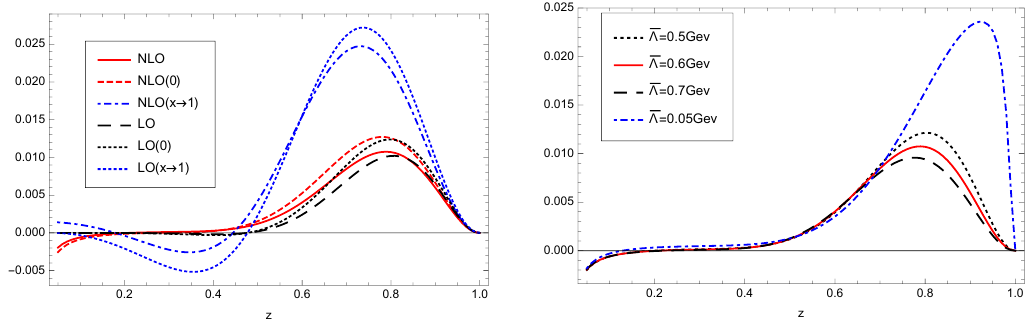
Figure 7 . Left figure: comparison of the gluon FF obtained in different approximations. Right figure: ¯Λ dependence of gluon FF at